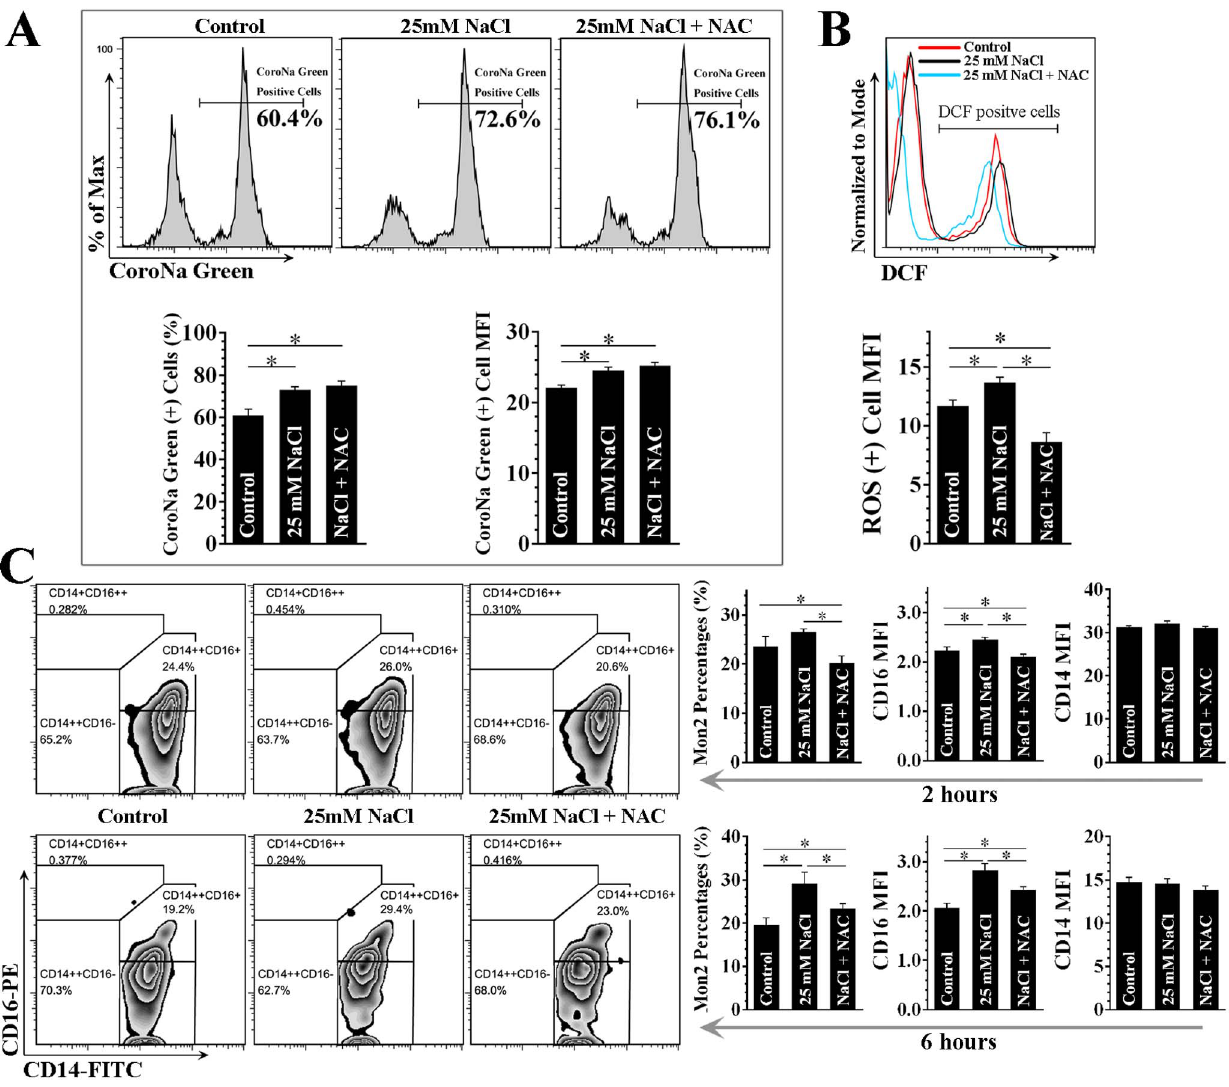
Figure 6. ROS dependent shift towards CD16 positivity in purified human CD14 ++ monocytes induced by increased extracellular [Na + ] (25 mM). Figure A shows CD14 ++ monocyte intracellular [Na + ] detected by CoroNa Green. B shows intracellular ROS production measured by 2 9 , 7 9 -dichlorofluorescein (DCF) flow cytometry in CD14 ++ monocytes. C shows monocyte subset phenotyping using CD16 and CD14 after CD14 ++ monocytes were incubated for 2 hours (the upper panel) and 6 hours (the lower panel). N-acetylcysteine (NAC, 2 mM) was used as ROS scavenger. All results are derived from 3 independent tests. MFI indicates median fluorescence intensity; Mon2 indicates CD14 ++ CD16 + monocytes. * P , 0.05. Table 5 . In general, lipid profiles remained stable, despite a slight decrease of high density lipoprotein cholesterol. There was a statistically suppressed serum aldosterone level during the high-salt period, while the dynamics of plasma renin activity and angiotensin II did not reach statistical significance.